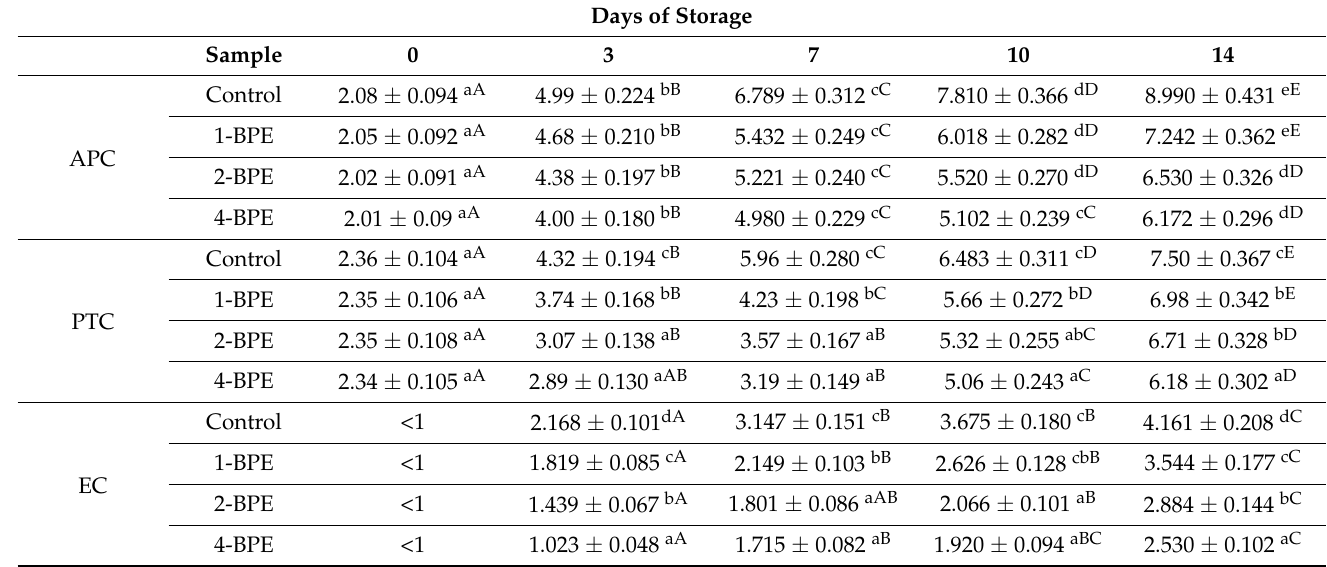
Table 6. Effect of films on the microbial load of APC, PTC and EC (log CFU/g) of raw minced meat samples stored at 4 ◦ C for 14